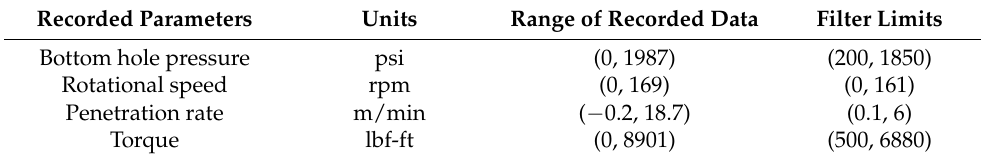
Table 2. Intervals for filtering data.